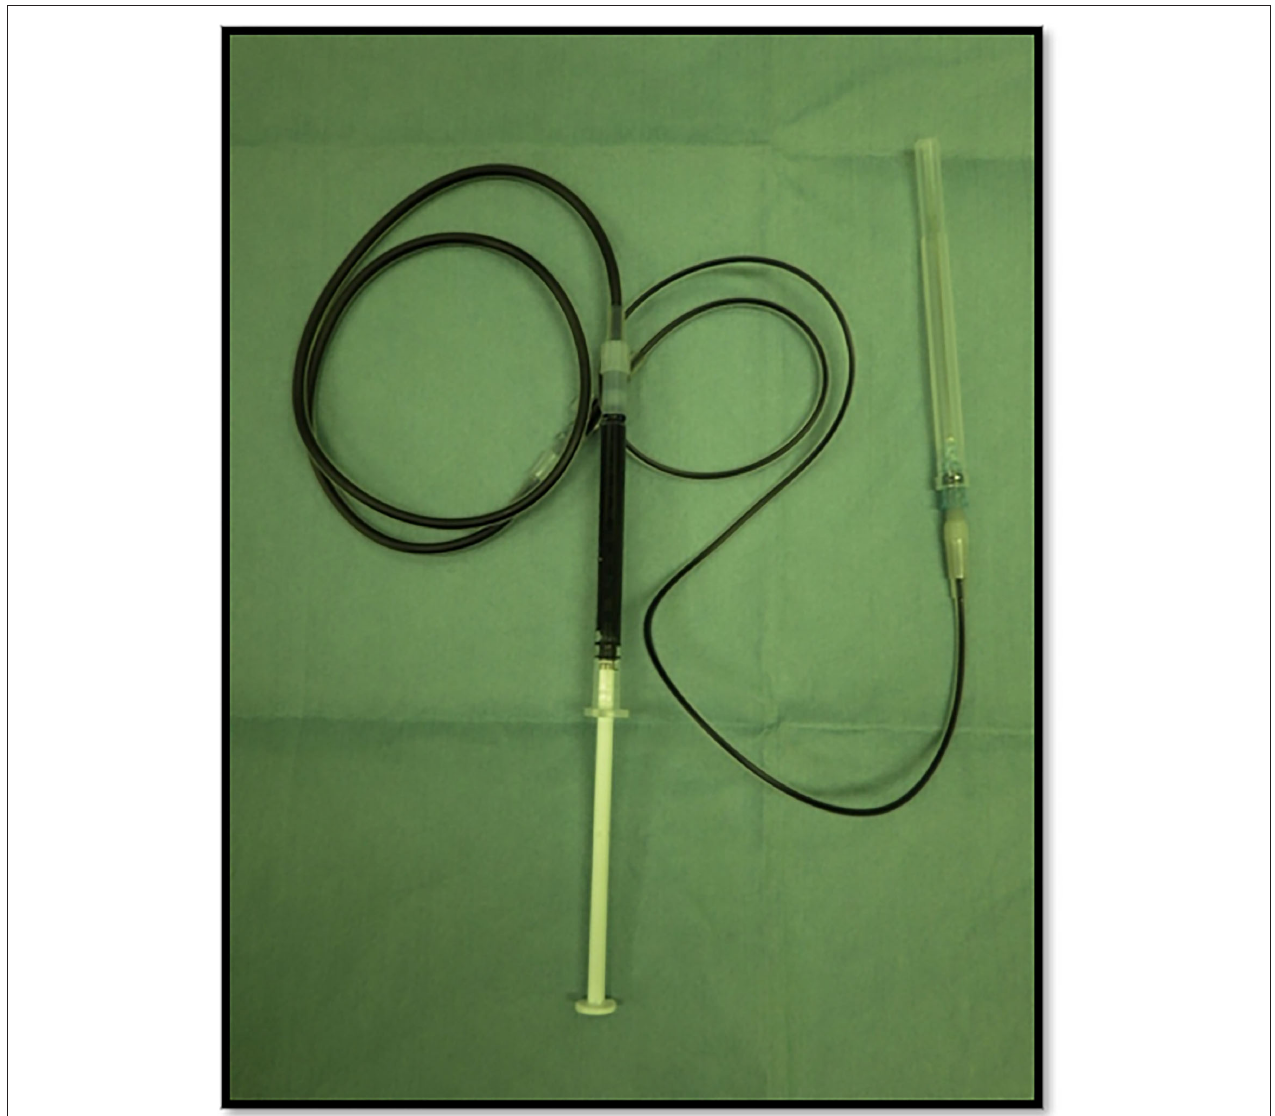
FIGURE 1 | The indigo carmine injection set and indigo carmine dye-filled